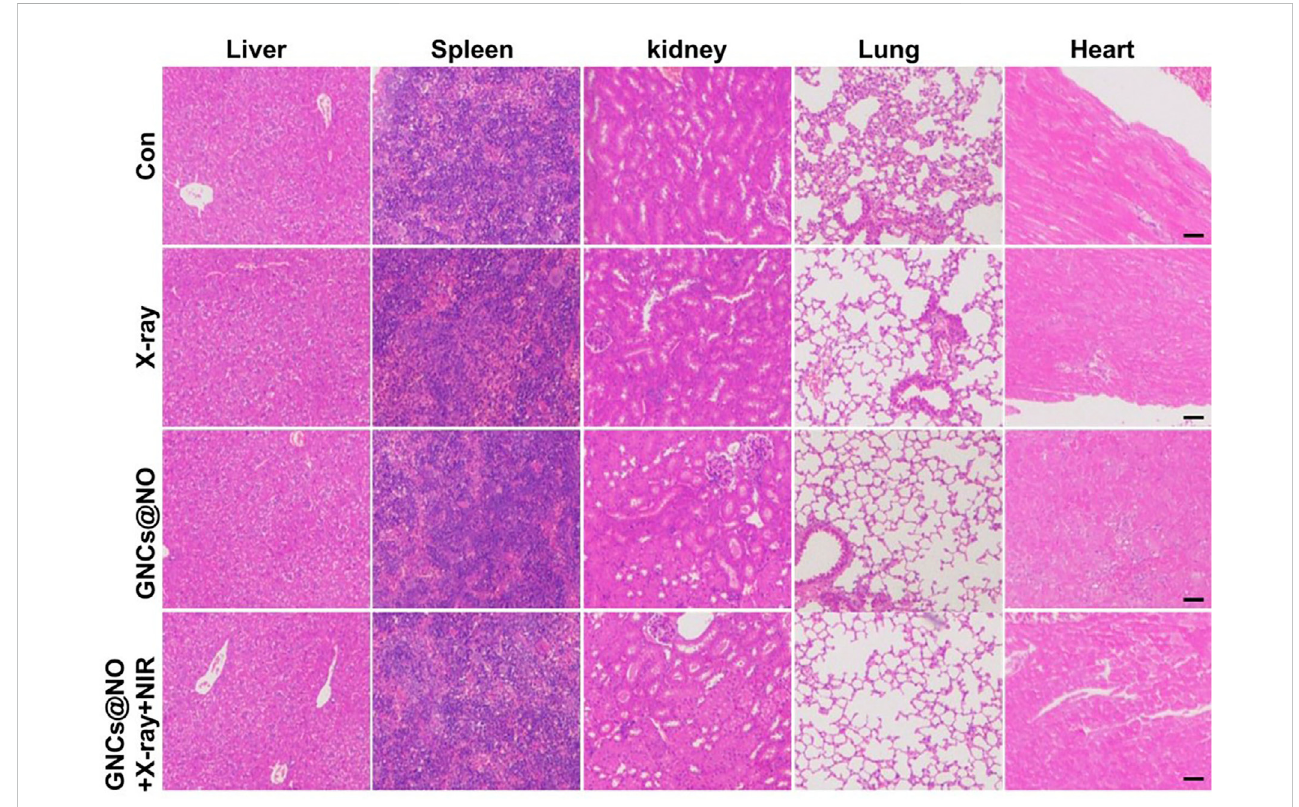
FIGURE 6 Histopathology of the livers, spleens, kidneys, lungs, and hearts from MCF-7 tumor-bearing mice from each group. Scale bar = 50 μ